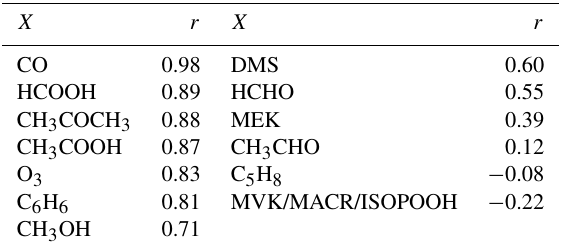
Table 3. Pearson correlation coefficients ( r ) between the excess of chemical compound X ( (cid:49)X ) and the excess of the typical BB marker CH 3 CN during the BB